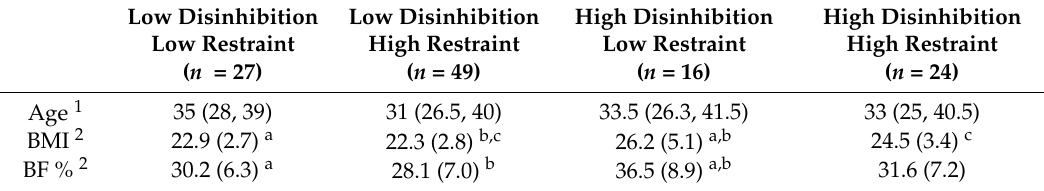
Table 5. Participant characteristics according to the level of Restraint and